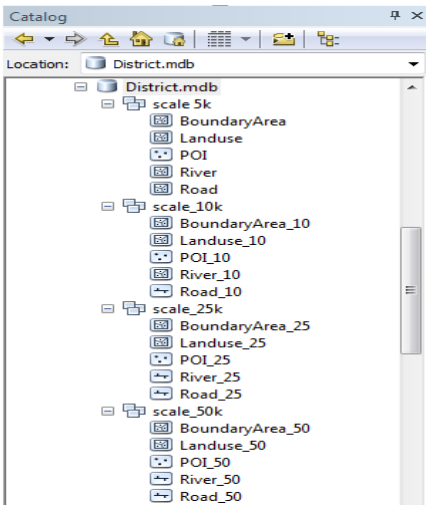
Figure 1: Multi-scale in separated database, with no connected topology between LoD and attribute redundancy.